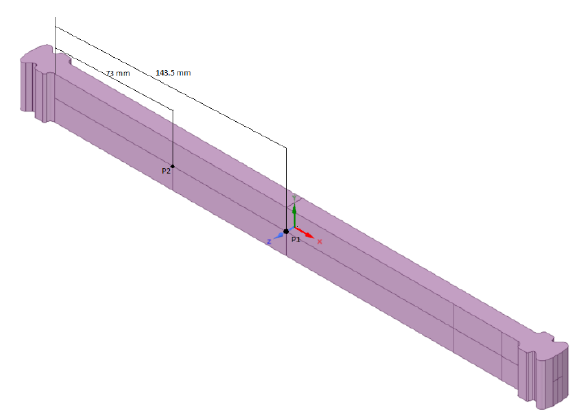
Figure 8. Measurement points, (P1) for first and (P2) second flexural mode.